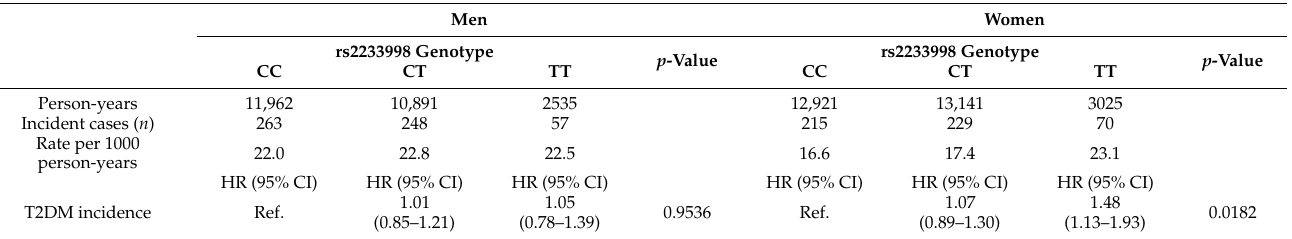
Table 4. Adjusted hazard ratios (with 95% confidence intervals) for type 2 diabetes mellitus